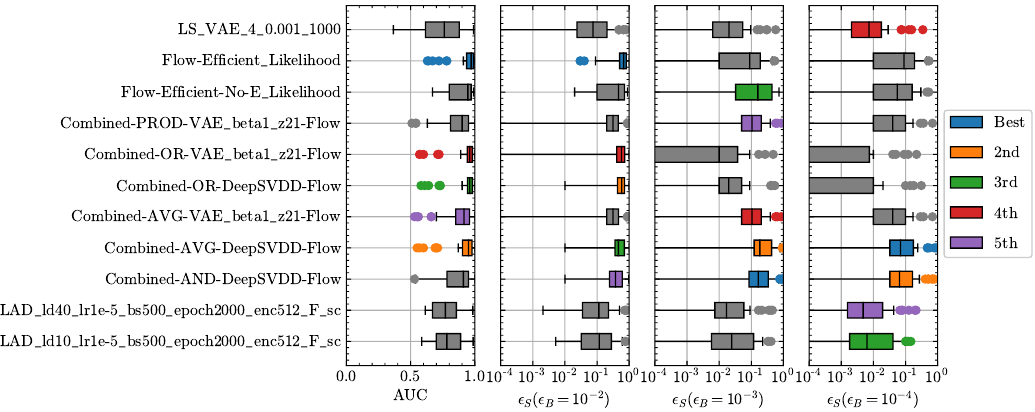
Figure 14: Box plots summarizing the anomaly detection techniques applied to all of the new physics signals. The colors denote the techniques that have the highest average